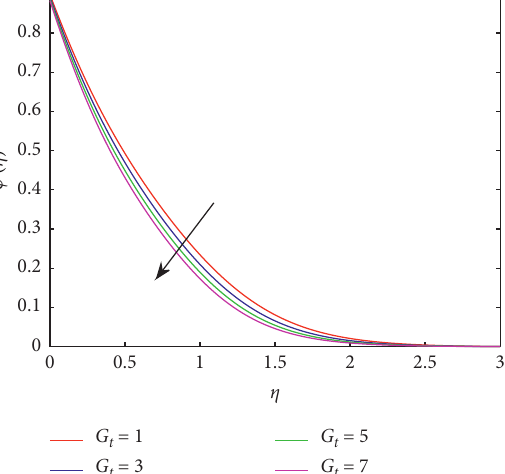
Figure 19: Variation due to Nb in ϕ ( η ) .